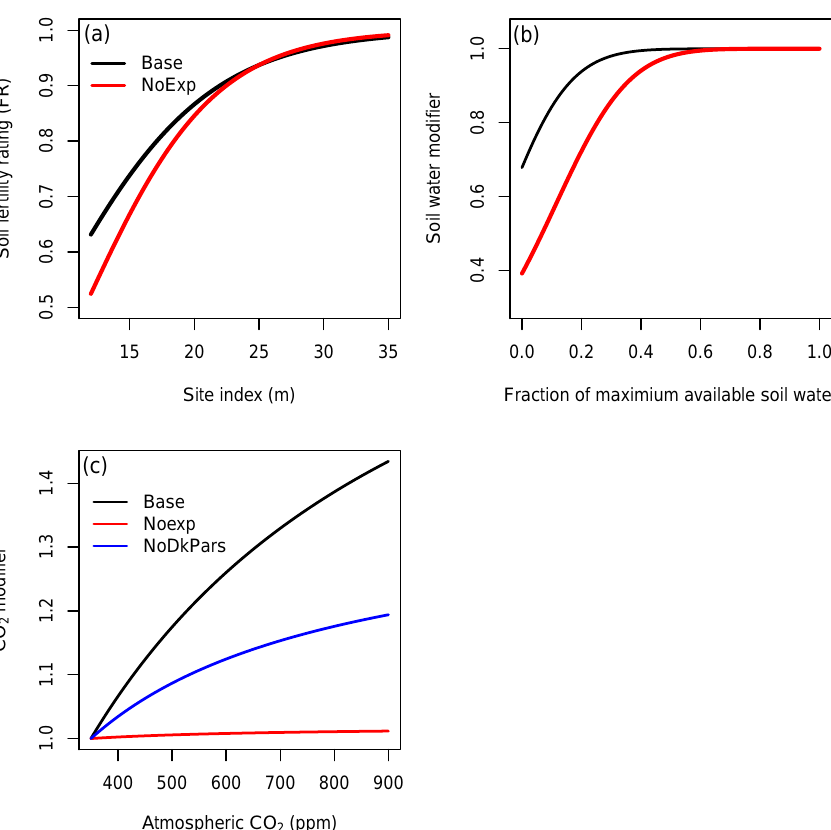
Figure 6. Optimized environmental response functions in the 3-PG model for the (a) soil fertility influence on photosynthesis, (b) available soil water influence on photosynthesis and conductance, and (c) atmospheric CO 2 influence on photosynthesis. The function shapes were derived from the parameters in the Base, NoExp, and NoDkPars assimilations (Table 4).